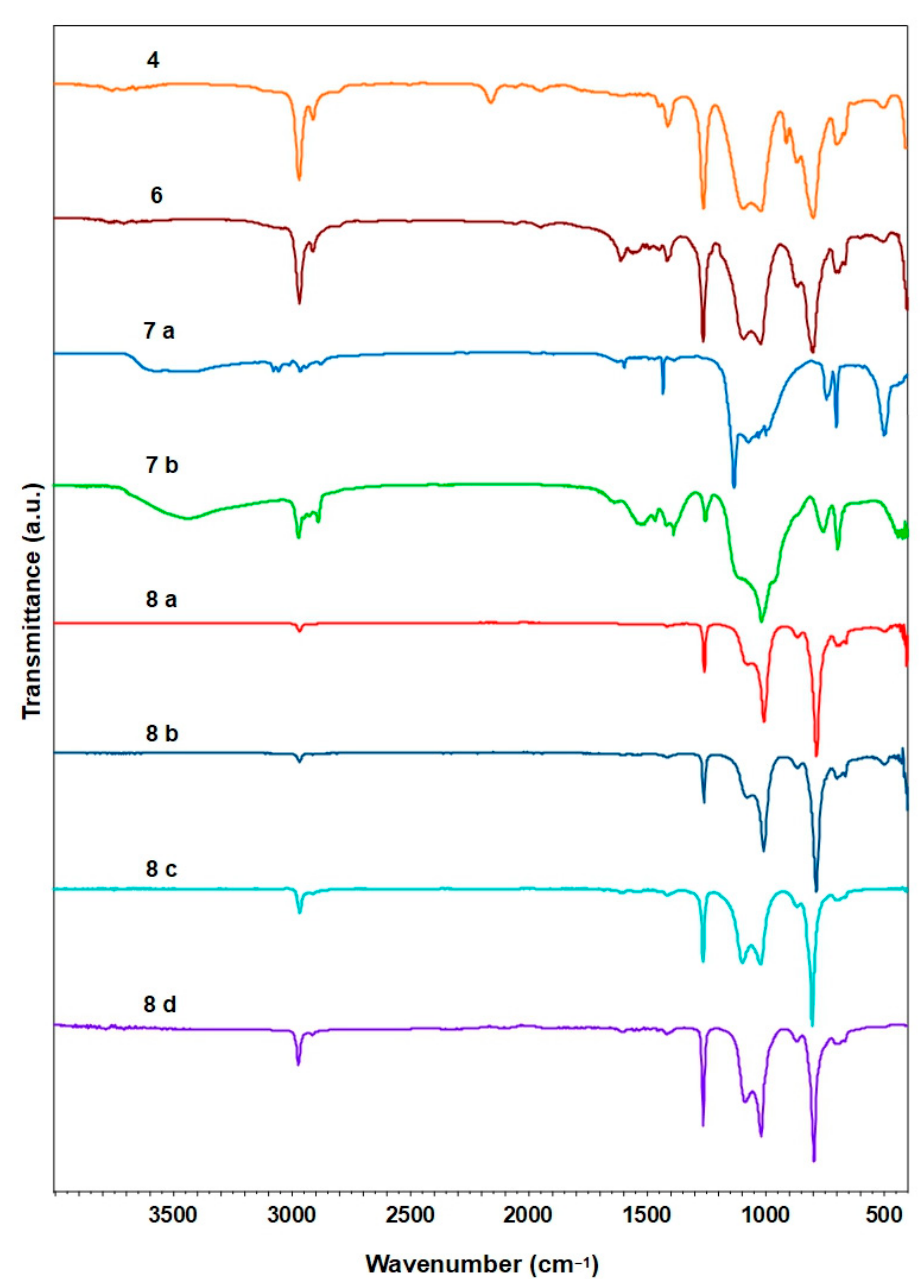
Figure 3. FTIR spectra of the precursors and cross-linked polymers.